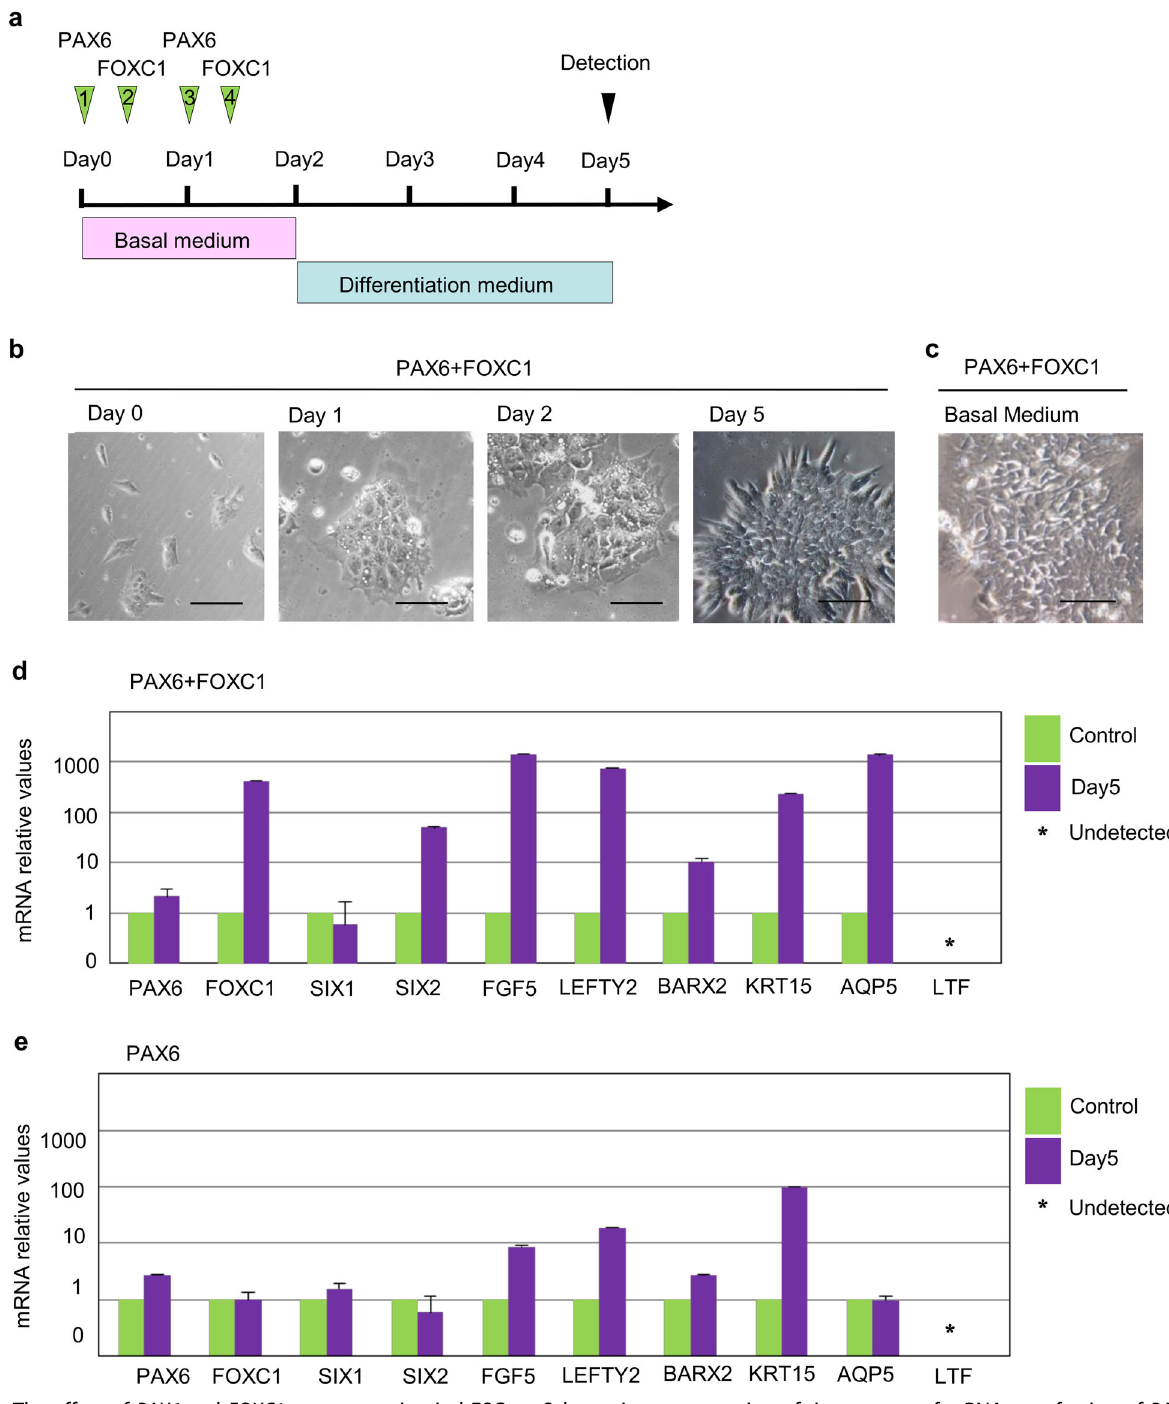
Fig. 3 The effect of PAX6 and FOXC1 overexpression in hESCs. a Schematic representation of time course of mRNA transfection of PAX6 and FOXC1 . b Phase-contrast images of hESCs transfected with PAX6 and FOXC1 mRNAs. Scale bar 100 µm. c A phase-contrast image of PAX6 and FOXC1 transfected hESCs at Day 5 in basal medium. Scale bar 100 µm. d Relative mRNA expression levels of representative ectodermal markers (FGF5, LEFTY2), branching morphogenesis marker (BARX2), and lacrimal gland epithelial markers (KRT15, AQP5, and LTF) after transfecting PAX6 and FOXC1 mRNAs into hESCs. Quantitative PCR analyses of total RNA extracts on day 5, or the control cells also grown for the same length of time (5 days) as the experimental cells. Error bars represent mean ± SD of three samples. e Relative mRNA expression pro fi les of the developmental markers including lacrimal gland epithelial markers after PAX6 mRNA induction in hESCs on Day 5, or the control cells also grown for the same length of time (5 days) as the experimental cells. Error bars represent mean ± SD of three